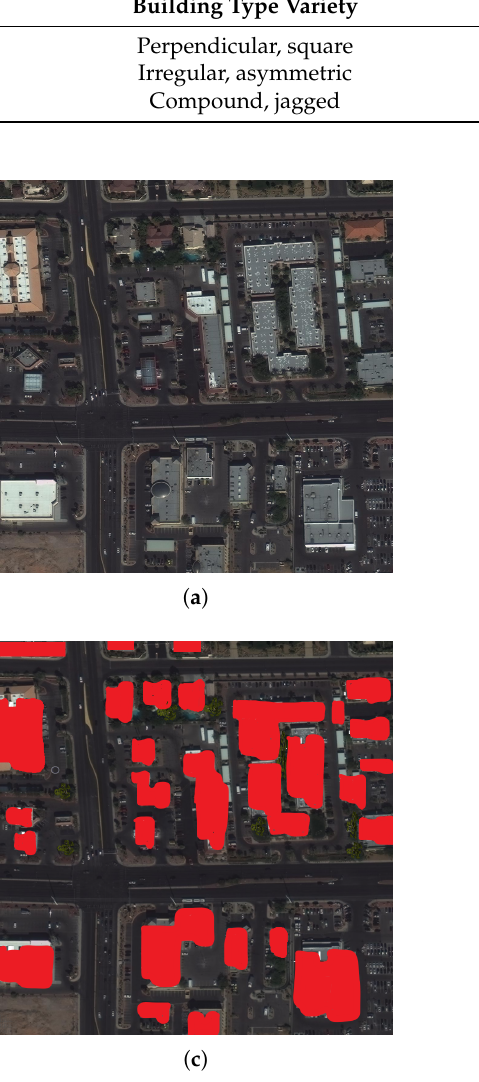
Figure 17. Validation process: ( a ) an original satellite image, unmarked for comparison in validation process; ( b ) the same satellite image, but, this time, real-life buildings are annotated and outlined; and ( c ) the same satellite image, but Gazebo-placed models are outlined